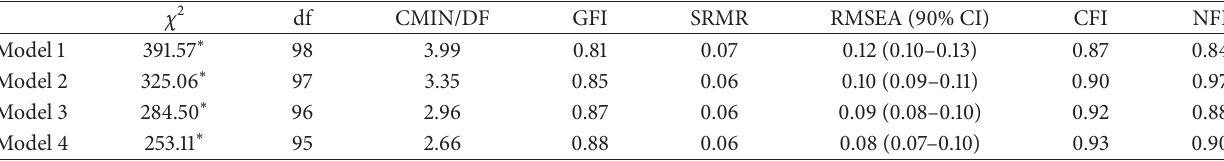
Table 3: Summary of fit indices from confirmatory factor